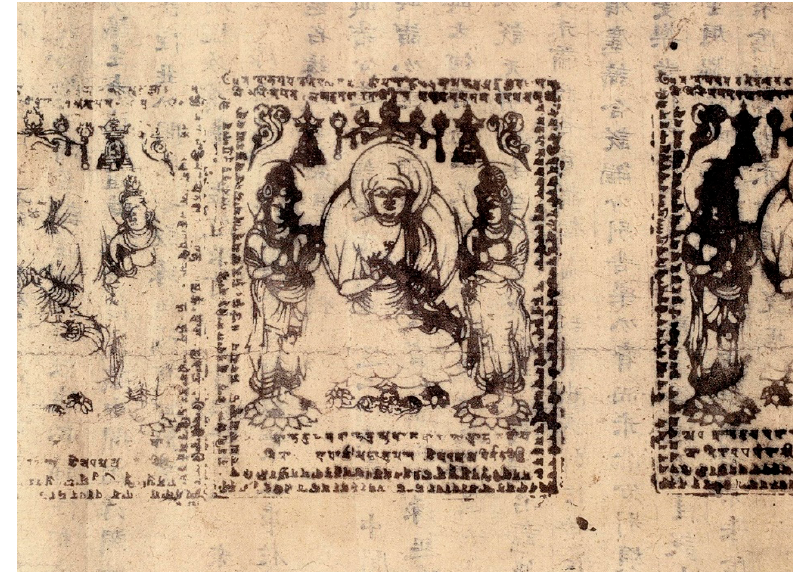
Figure 1. Misrakabhidharmah ṛ daya sastra (Ch. Za a pitan xin lun ), Fascicle 10, “Amitabha Triad Seal”, Dunhuang Manuscripts, Southern and Northern Dynasties, National Library of China. Source: Li 2008, Figure 1.